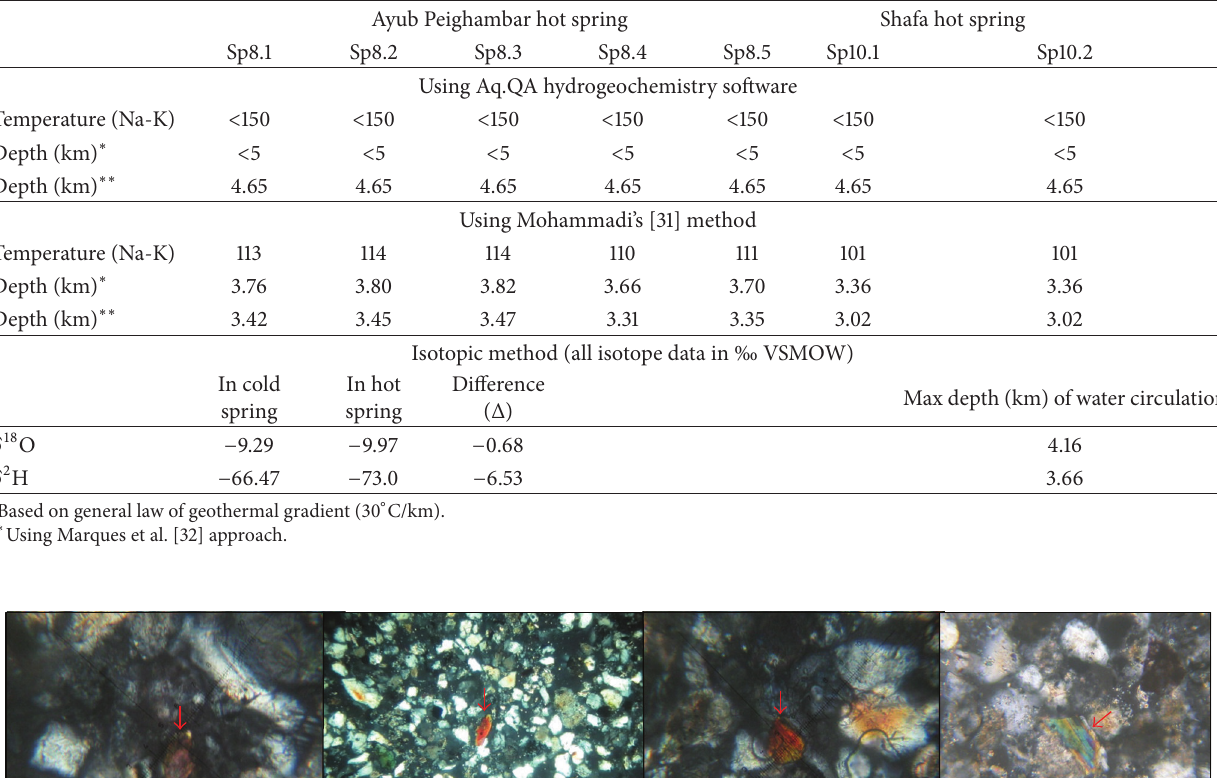
Table 2: Temperatures and depths of hydrothermal reservoirs for AP and SH hot springs, calculated based on Na-K geothermometers [28, 31], Aq.QA hydrochemical software [21], and isotopic method.